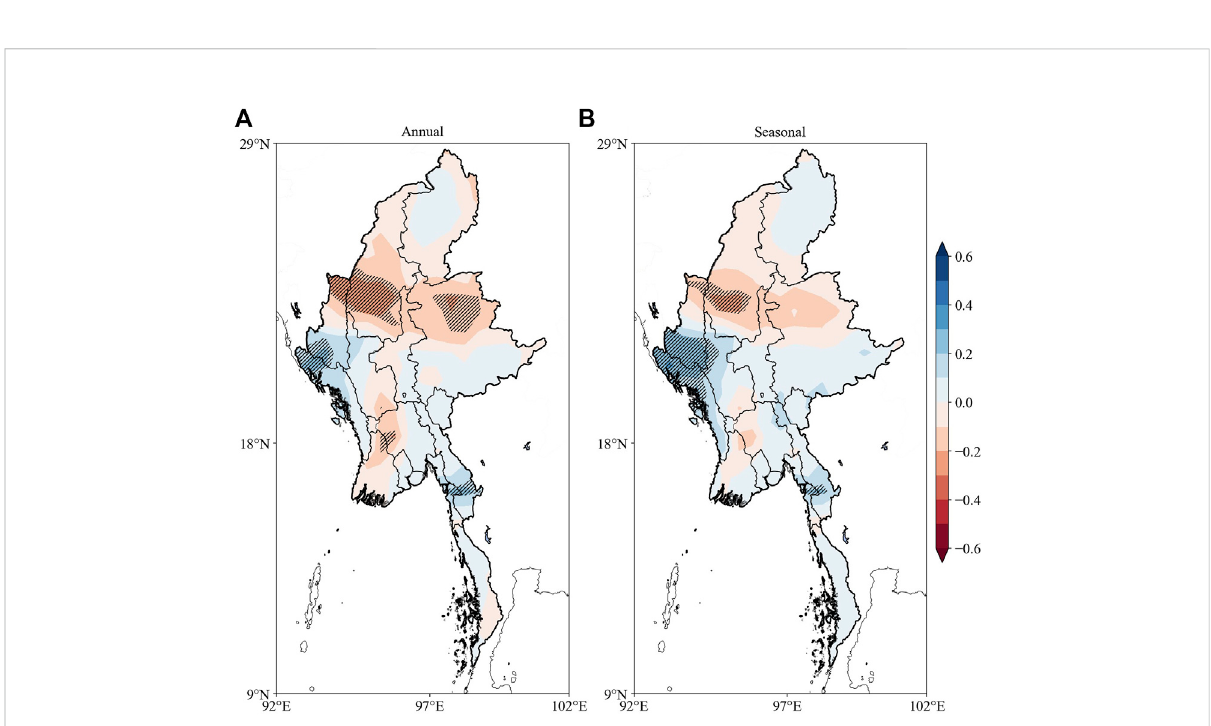
FIGURE 3 MKtrend test ofGPCC PREobservation for (A) annual and (B) seasonal precipitation. Hatches indicate signi fi cance at the90% con fi dence level.